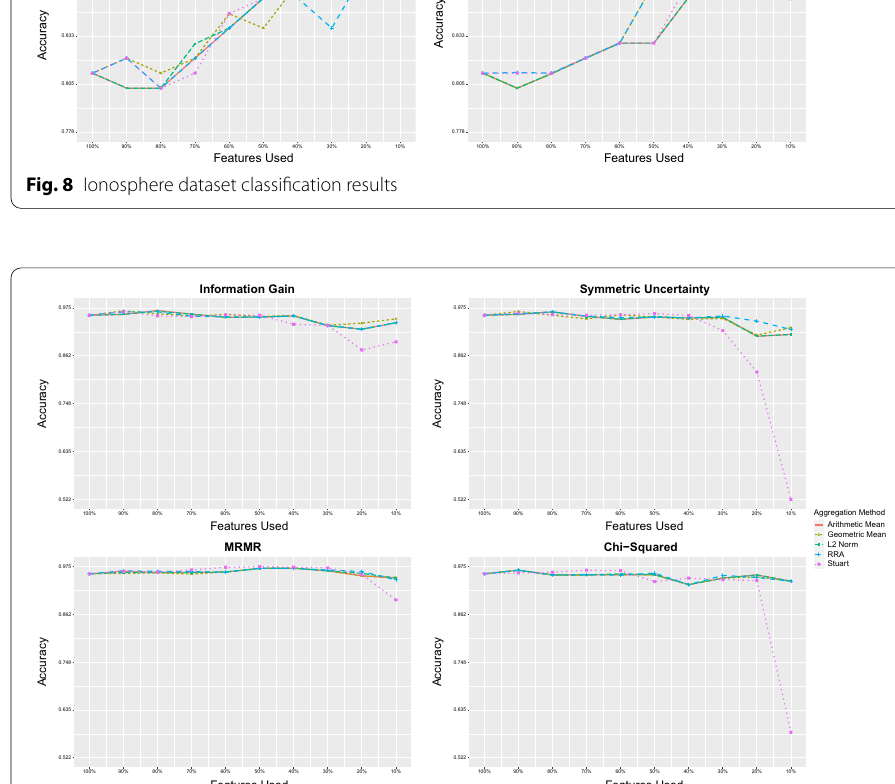
Fig. 9 Optdigits dataset classification